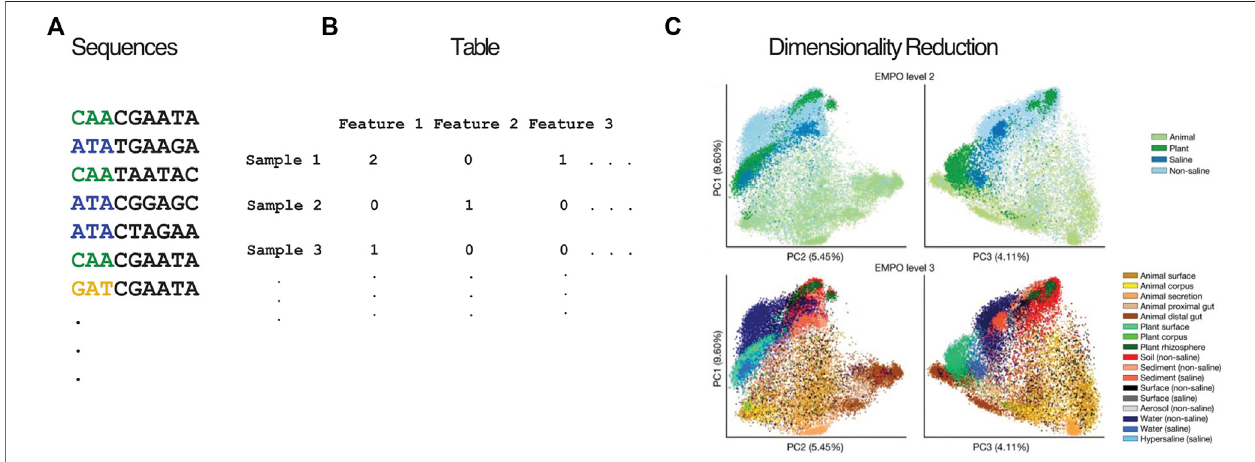
FIGURE1| Overviewofdimensionalityreductionpipeline.Nucleotidesequences (A) fromabiologicalexperimentareorganizedinafeaturetable (B) containingthe abundanceofeachfeature(e.g.,OTU,ASV,MAG)ineachsample. (C) BetadiversityplotsshowingunweightedUniFraccoordinatesofEMPannotatedbyEMPOlevels2 and 3. (C) is a derivative of Figure 2C from “ A communal catalogue reveals Earth ’ s multiscale microbial diversity ” by Thompson et al. (2017) used under CC BY